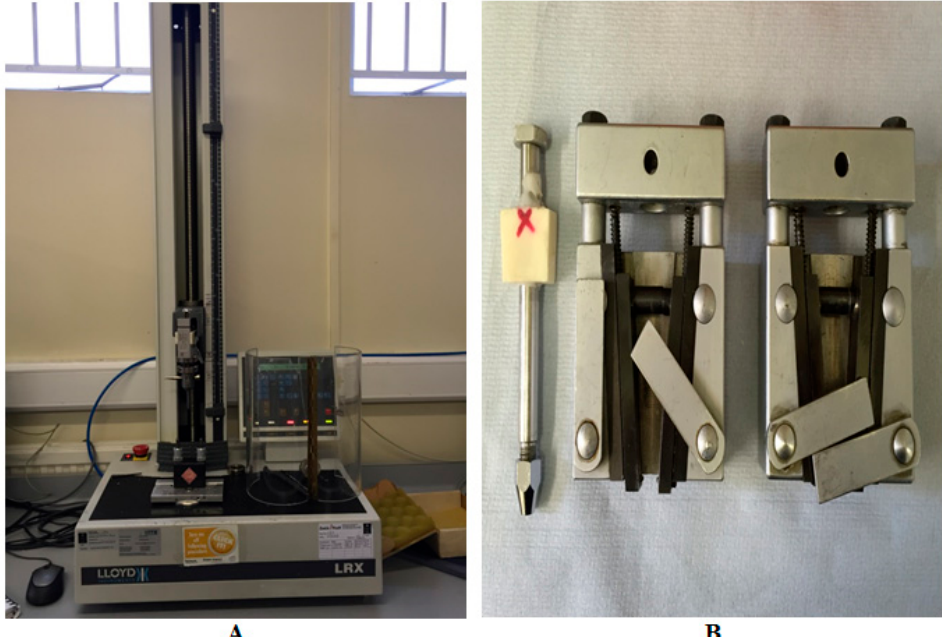
Figure 5 . ( A ) Fatigue chewing simulator machine. ( B ) From left to right: metallic holder, upper and lower part.